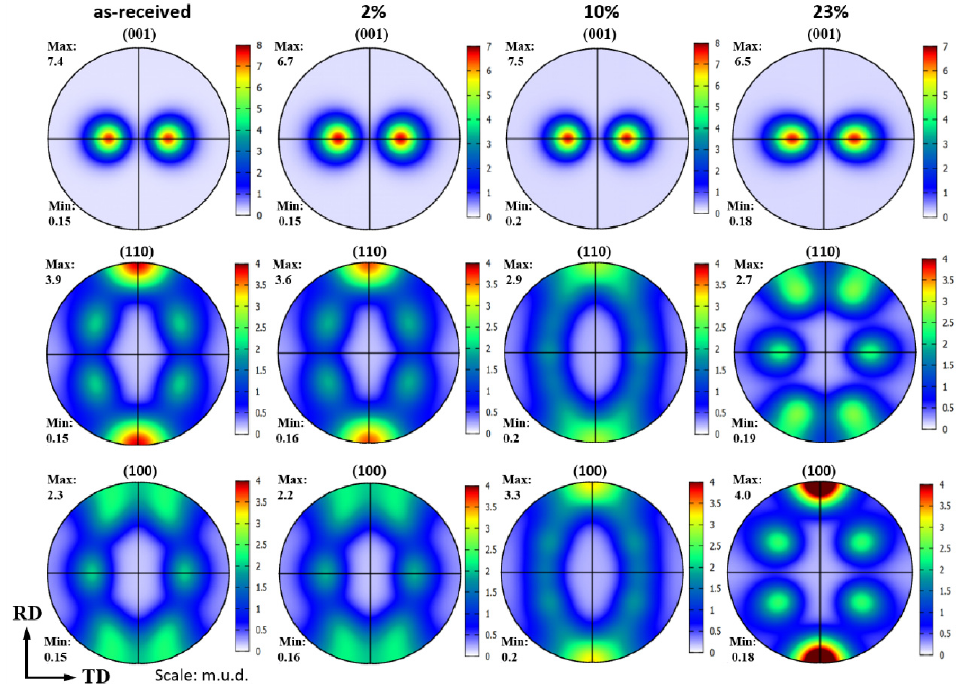
Figure 6. Calculated (001), (110) and (100) pole figures of the as-received and tensile-deformed Ti based on the texture parameters determined by X-TEX.